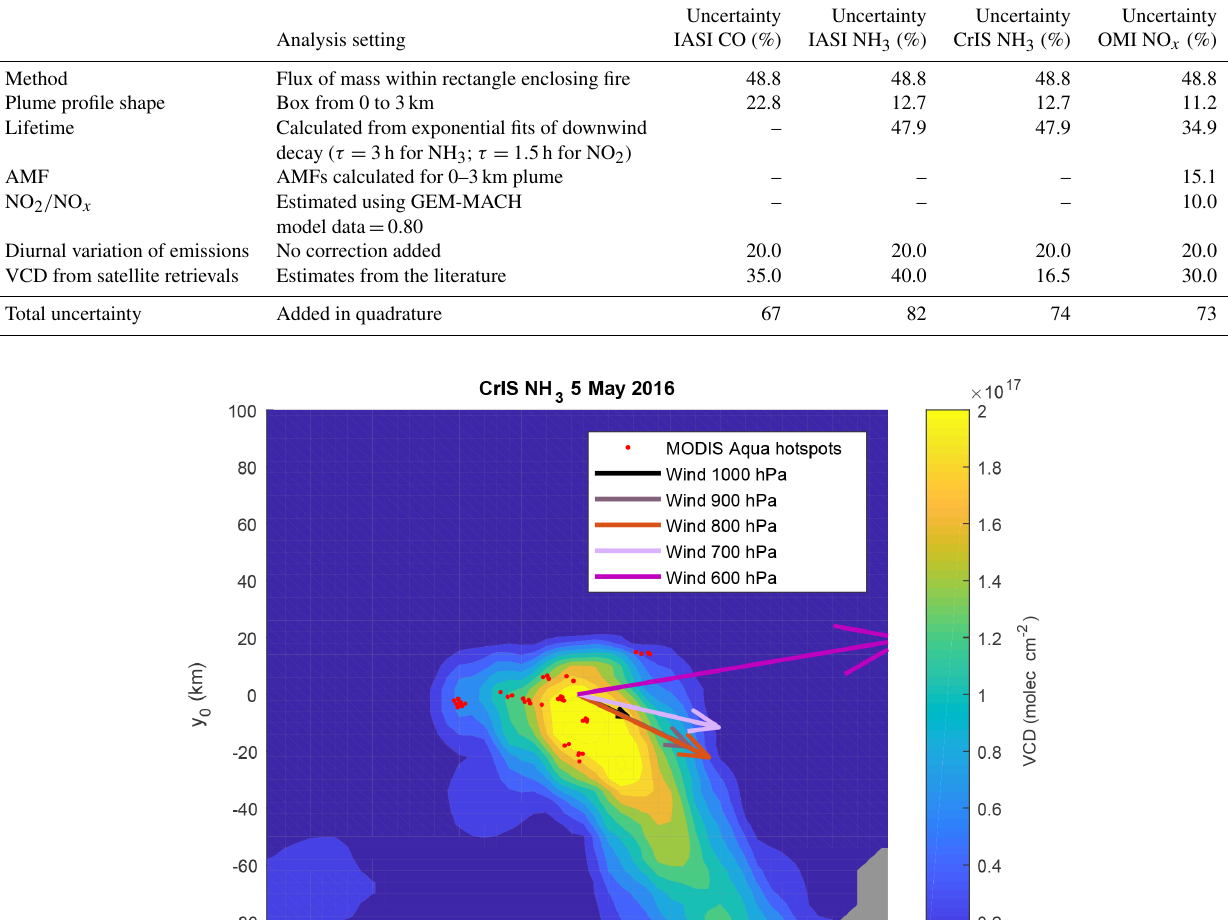
Table 1. Summary of analysis settings and associated uncertainty for satellite emission estimates.